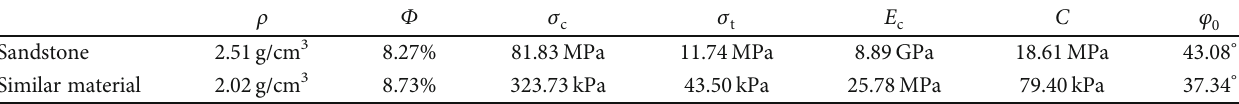
Table 1: Physical-mechanical properties of the prototype and similar